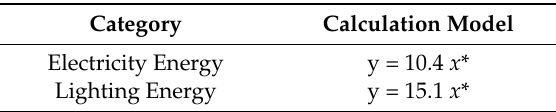
Table 9. Lighting and Electrical Energy